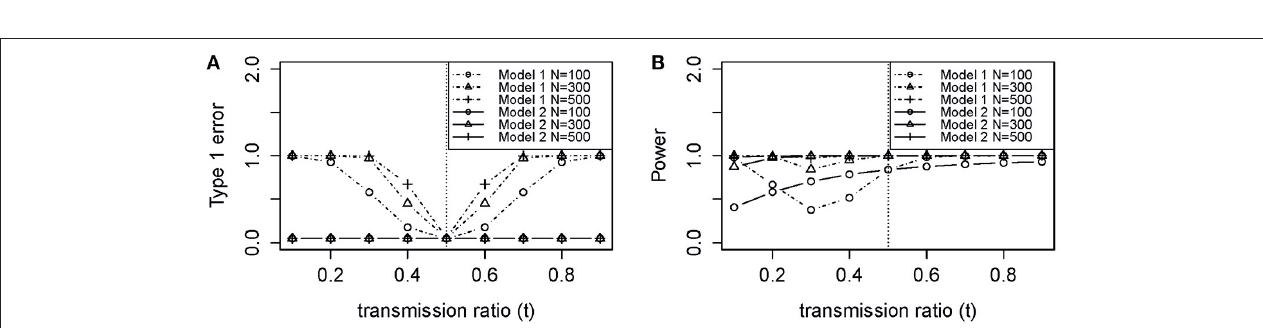
FIGURE 2 | Empirical (A) type 1 error and (B) power of models 1 (Unadjusted) and 2 (Adjusted).